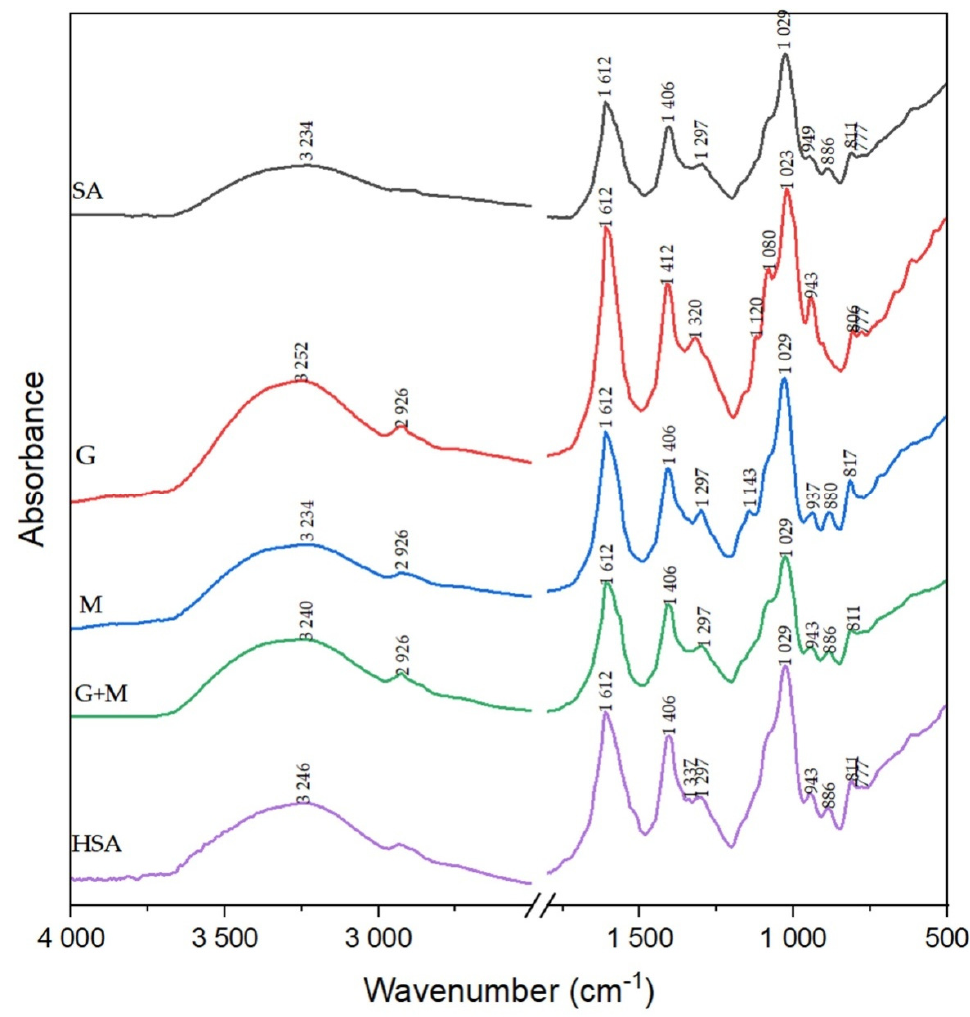
Figure 2. FTIR spectrum of sodium alginate (SA) and acidic (G, M and G + M fractions) and oxidation (HSA) depolymerization products .